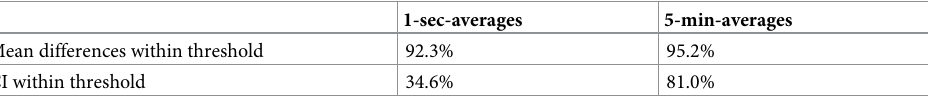
Table 3. Percentage of patients who met the threshold of 5 rpm for both the mean differences as well as CI for 1-sec averages and 5-min